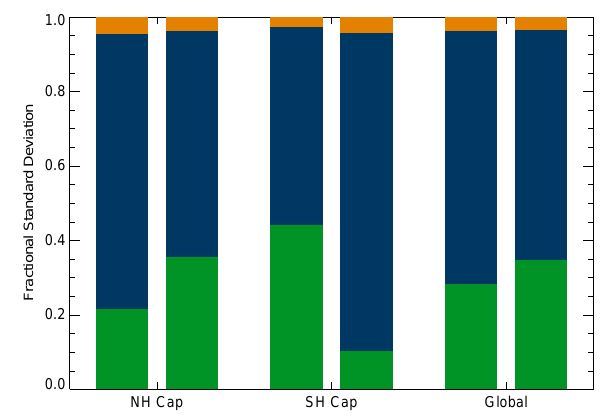
Fig. 5. Estimates of the fractional uncertainty in the date of return to 1980 values of total-column ozone amounts due to different sources of uncertainty, for three different geographical regions and seasons. The coloured areas indicate the fractional contribution of that type of uncertainty to overall uncertainty in the date of ozone return date (orange - internal variability, blue - model uncertainty, green - scenario uncertainty). Bars are shown for the northern polar cap during spring (60-90 ◦ N, March) for the southern polar cap during spring (60-90 ◦ S, October) and for the global and annual. Left-side bars show calculations of scenario uncertainty using four model integrations run with SRES scenarios. Right-side bars shows calculations of scenario uncertainty using three integrations of CAM3.5 run with RCP scenarios. here would require a large ensemble of models to all run at least three different GHG